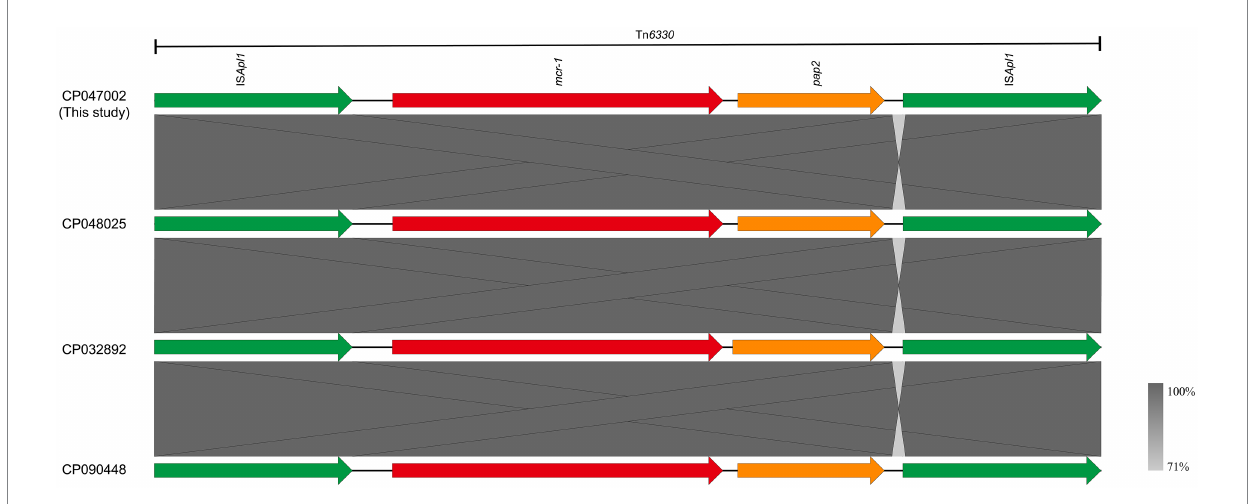
FIGURE 2 Genetic environment of mcr-1 , located on the chromosome of Escherichia coli J-8 (CP047002), in this study and compared with GZEC065 (CP048025), SCEC020022 (CP032892), and PT62 (CP090448). Dark grey shading denotes regions of homology (>99% identity nucleotide